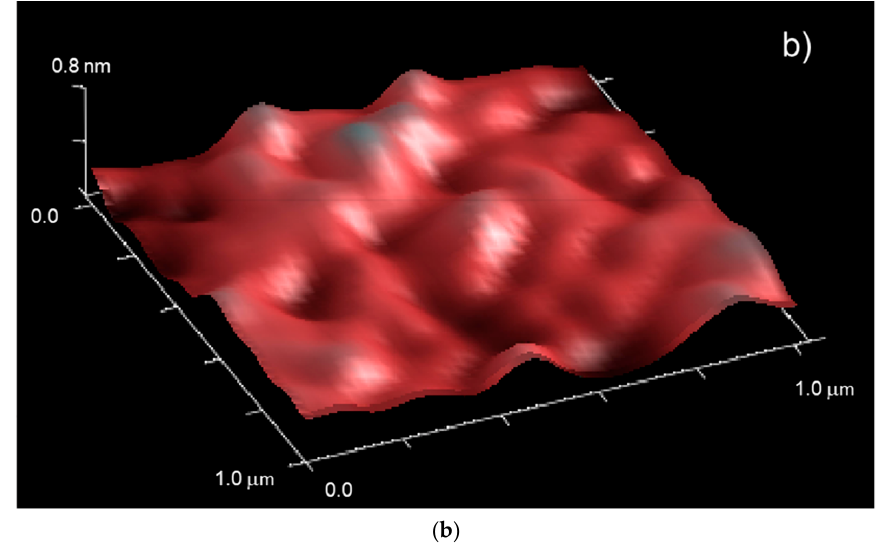
Figure 3. Three-dimensional (3D) atomic force microscope (AFM) images for the original untreated PET-SiOx film: ( a ) uncoated PET side and ( b ) SiOx-coated side. As expected, the SiOx coating strongly increases the surface water wettability of the film, as it comes out comparing the CAw values of the two sides of the substrate. The phenomenon is due to the higher polarity of the SiOx coating layer, with respect to the uncoated PET, which allows favorable Coulomb interactions (i.e., interactions among permanent–permanent dipoles, e.g., hydrogen bonds and interactions among permanent-induced dipoles) with the water droplets. On the other hand, almost no effect on the oil wettability was detected, since both sides of the films have similar CAo values, maybe due to the very low surface tension of the oil (27.5 mN/m at 25 °C [27]. It is well known, in fact, that the static contact angle θ is a function of the relative surface energies of the solid–liquid (SL), gas–liquid (GL), and gas–solid (GS), as shown in Figure 4.